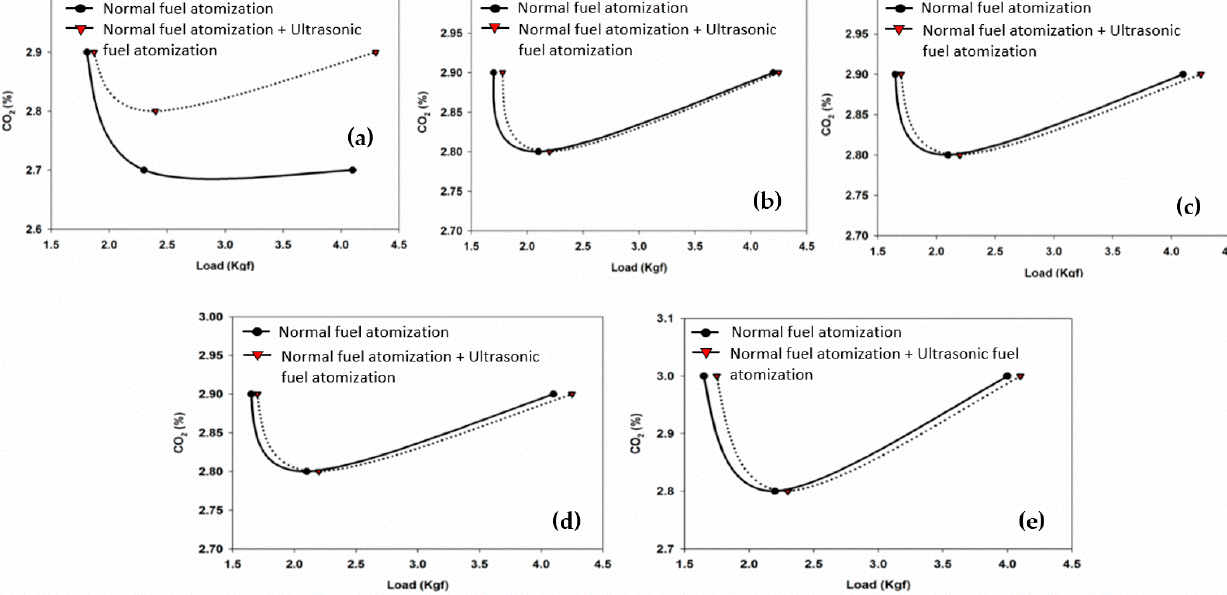
Figure 5. Plots of CO 2 emission against the engine load for all the different fuel types: ( a ) kerosene, ( b ) B20, ( c ) B50, ( d ) B75 and ( e ) B100.